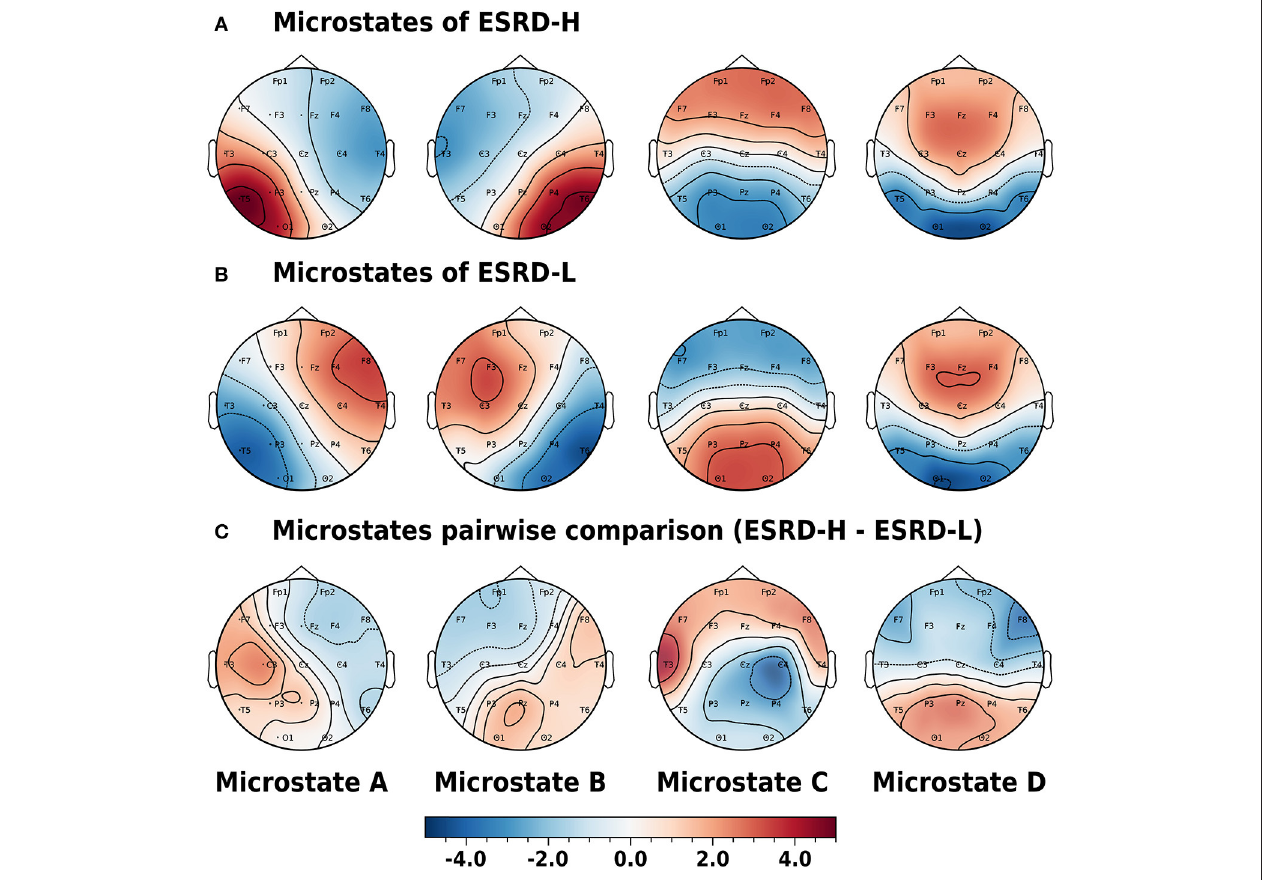
FIGURE 3 | Phase-independent microstate prototypes characterized by Z-score are orderly demonstrated in the A, B, C, and D patterns of the (A) ESRD-H and (B) ESRD-L groups. (C) Pairwise comparisons for each channel are represented by t -values (ESRD-H - ESRD-L). No statistically significant differences were observed in any of the topographic maps. All values are represented by color bars.